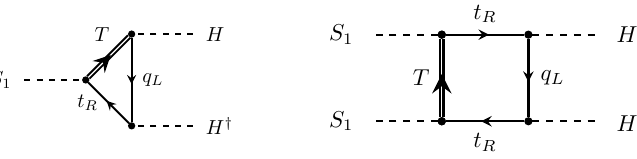
Figure 13 . Loop diagrams leading to e(cid:11)ective interactions coupling the (cid:12)rst KK resonance of the bulk scalar S 1 to the higgs